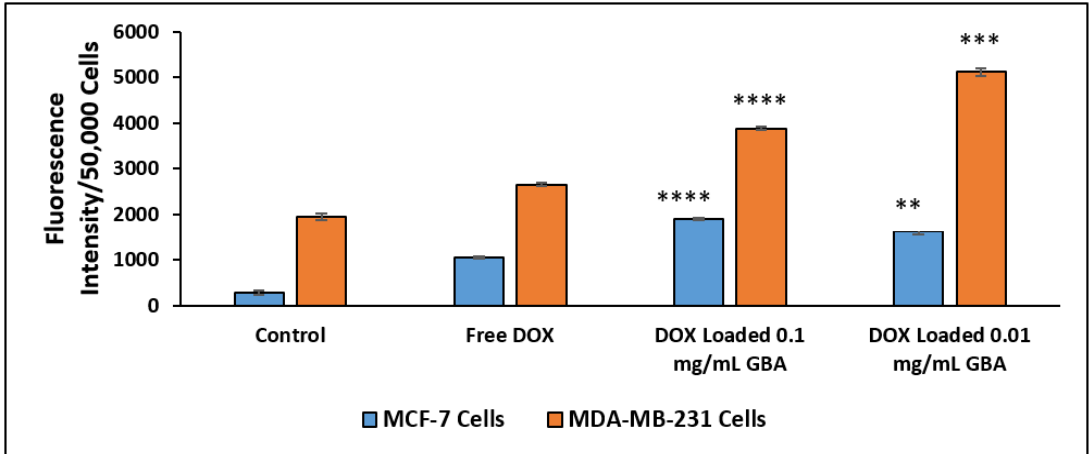
Figure 9. Fluorescent intensity measurement of free DOX, DOX loaded with 0.01 and 0.1 mg / mL GBA after 4 h of treatment in MCF-7 and MDA-MB-231 cells. p values between 0.001 and 0.01 (**) were represented to be very significant, p values between 0.0001 and 0.001 (***) were represented to be highly significant, and p values < 0.0001 (****) were represented to be extremely significant.